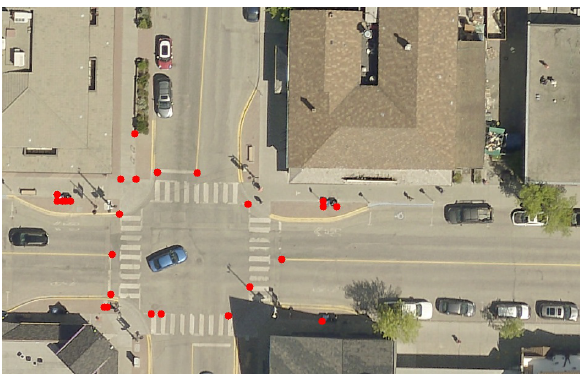
Figure 3. Homography points of the aerial image